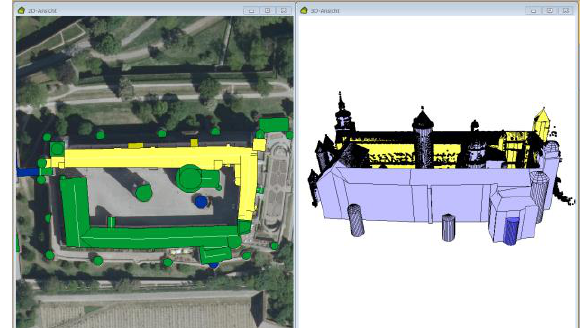
Figure 1. DOP with building ground plans (left) and corresponding laser point cloud of a building in yellow which needs to be edited (right) The degree of automatic roof recognition can be expressed by the post-editing rate. It is basically dependent on the density and type of the buildings. In modern cities for example the post- editing rate is only 15 %. The higher the percentage of historical buildings, the lesser the automatic recognition rate of the